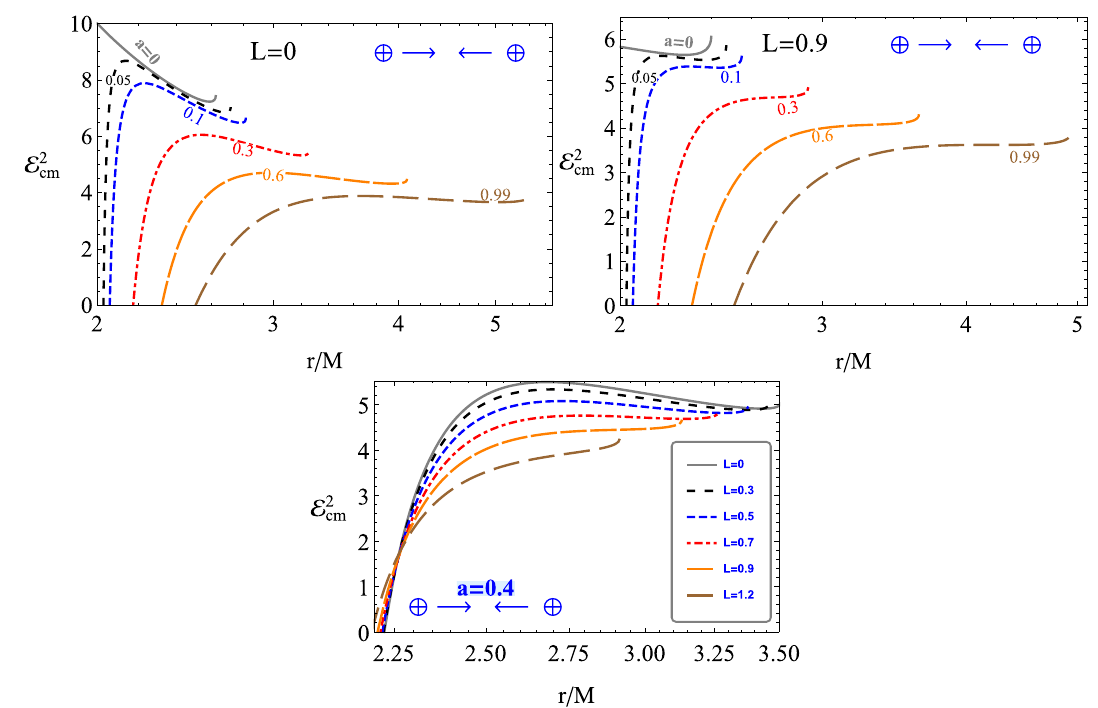
Fig. 17 Radial dependence of the center-of-mass energy of two collisions of positively charged particles near a singularity-free black hole in conformal gravity for different values of the conformal parameter L and the spin parameter a . Units in which M = 1